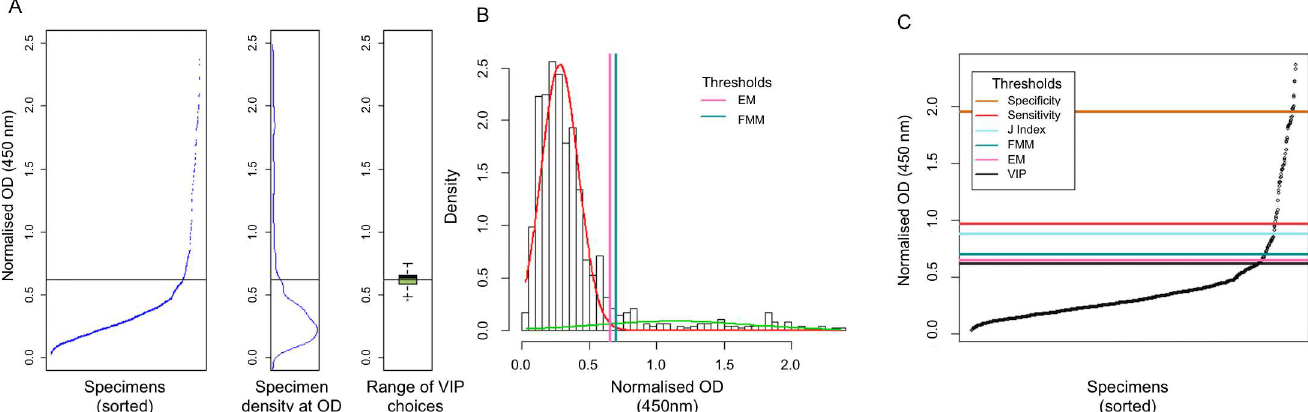
Fig 2. Threshold values for Laos (1–9 year olds) data. Panel A shows the threshold as determined by visual inflection point analysisby 12 volunteer individuals. Volunteershad access only to the data presentedin the leftmost panels, which shows sorted OD 450 values. The second panel in A shows the density of data points for the sample whilethe third panel in A shows a box and whiskerplots with the range of threshold values that were selectedby the 12 volunteers. The box shows the inter-quartile range for the values, with the thick horizontalline markingthe medianvalue. Whiskers show the upper quartileplus 1.5x the range betweenthe 1 st and 3 rd quartiles. Outliers are shown by an open circle. Panel B shows the thresholds set by the finite mixture model and expectation-maximisation algorithm. Density plots of normalised OD values and thresholds, showingthe FMM estimated distributionfunctions of ‘seronegative’ specimensin red and ‘seropositive’ specimensin green. Vertical lines show the thresholdvalues determined by the finite mixture model (right-most line) and the expectation-maximisation algorithm(left-most lines). Panel C compares the thresholdspecifications by four different methods. Scatterplots show the normalised and sorted OD 450 values with horizontal lines markingthe thresholdsspecifiedby VIP (OD 450 = 0.619), EM (OD 450 = 0.650), FMM (OD 450 = 0.696), ROC curve maximising Youden’sJ-index(OD 450 = 0.870), ROC curve with sensitivity > 80% (OD 450 = 0.968) and ROC curve with specificity > 98%(OD 450 = 1.951).